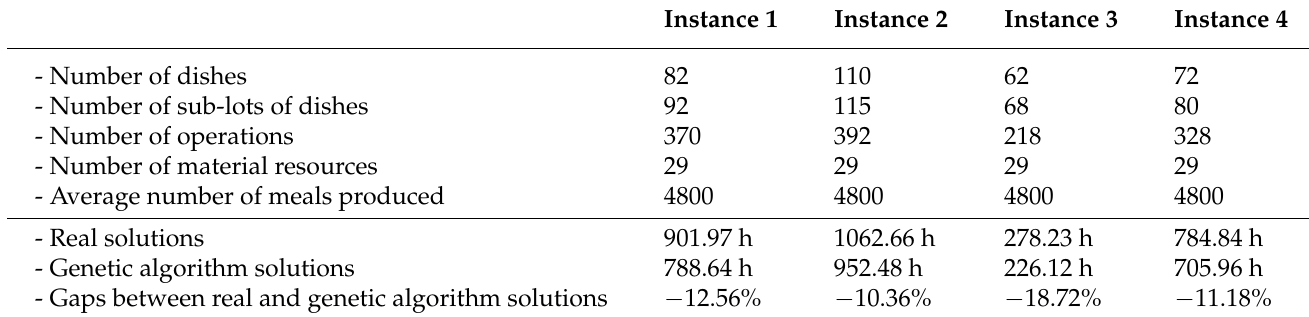
Table 10. Comparison between the real and genetic algorithm solutions for some examples of production